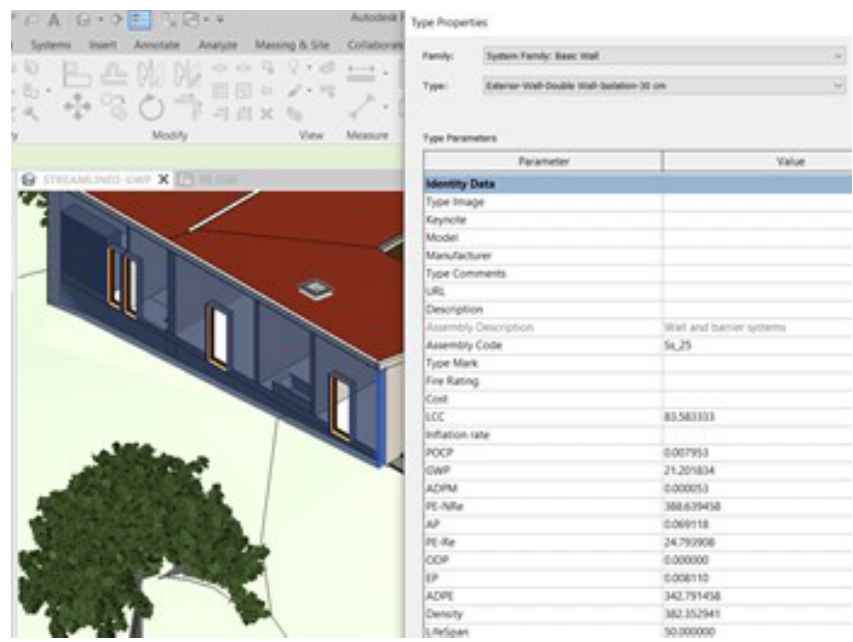
Figure 5. Environmental Impacts incorporated in shared parameters of a wall in Revit.